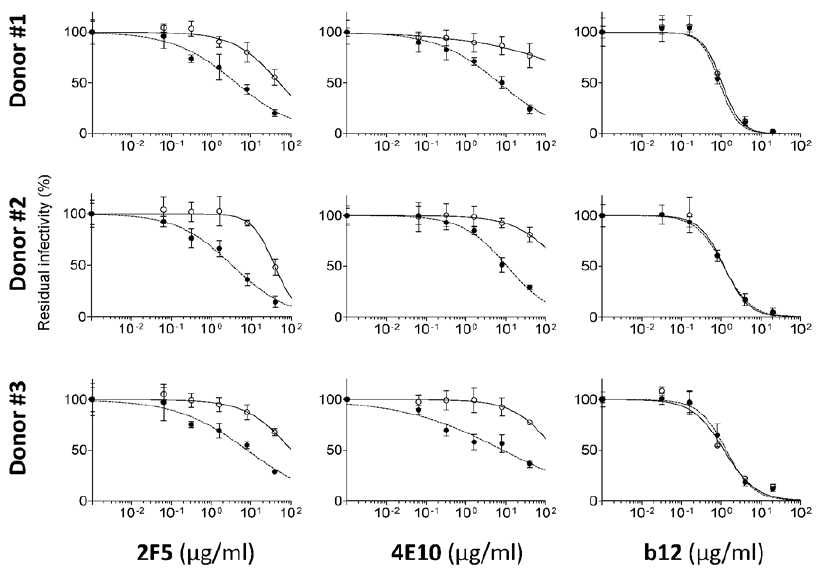
Figure 6. Nef alters the neutralization sensitivity of virus derived from primary cells. Neutralization of wild-type and Nef-defective HIV- 1 NL4-3 pseudotyped with JRFL Env produced in PBMC from three different donors, with the indicated nAbs. Neutralization was performed three times independently. Shown are the mean values and SD.